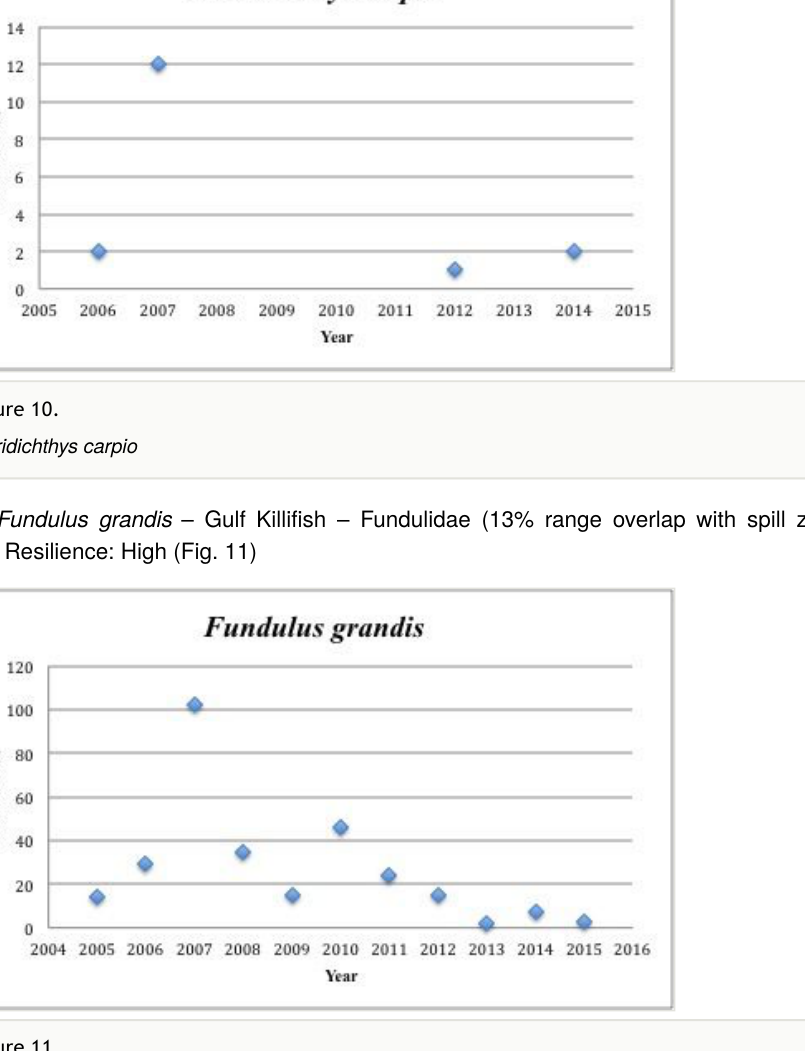
Figure 11. Fundulus